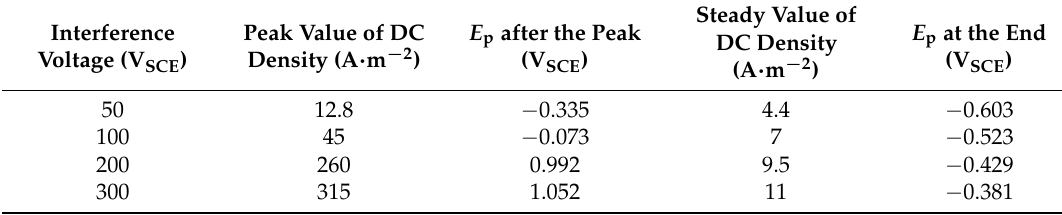
Table 3. DC density values and corresponding E p .